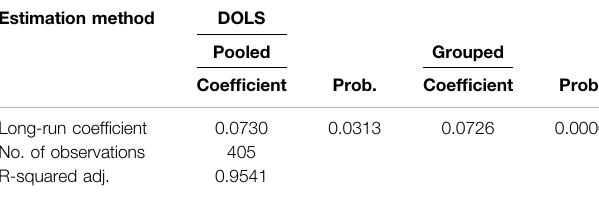
TABLE 4 | Estimation of cointegrating